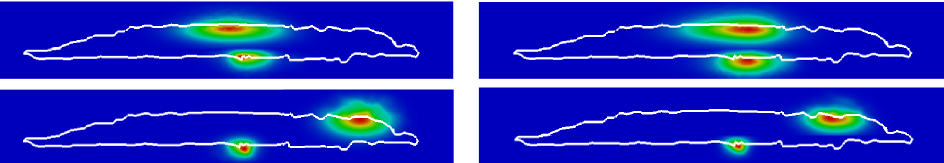
Figure 3. Simulations with two-dimensional models. ( Top ): GS for electrons and holes in the case of (cid:126) k · (cid:126) p for uniform In content ( left ) and VCA ( right ). ( Bottom ): GS for electrons and holes in the case of (cid:126) k · (cid:126) p for real In content ( left ) and for one RA configuration ( right ).